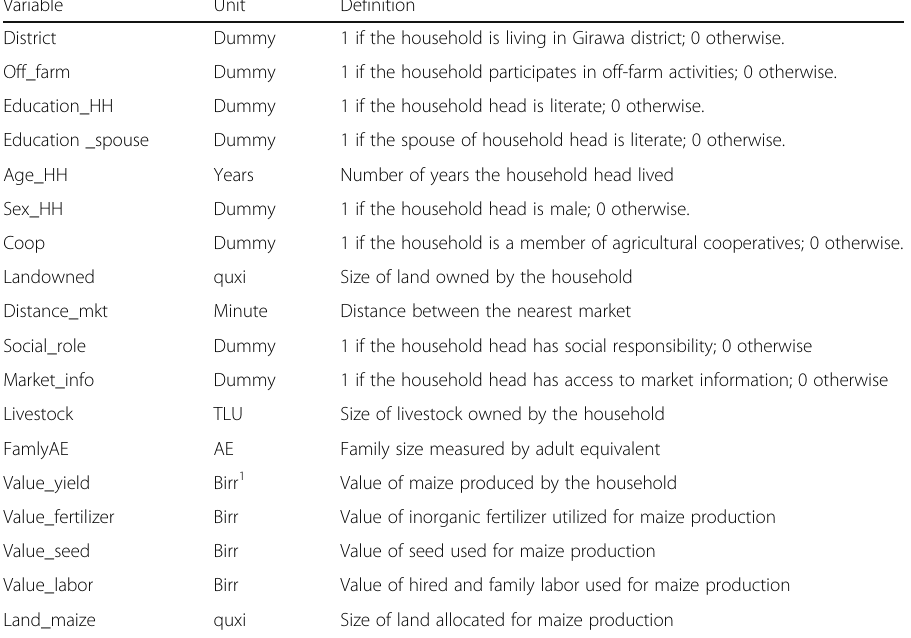
Table 9 Conversion factor for computation of adult equivalent